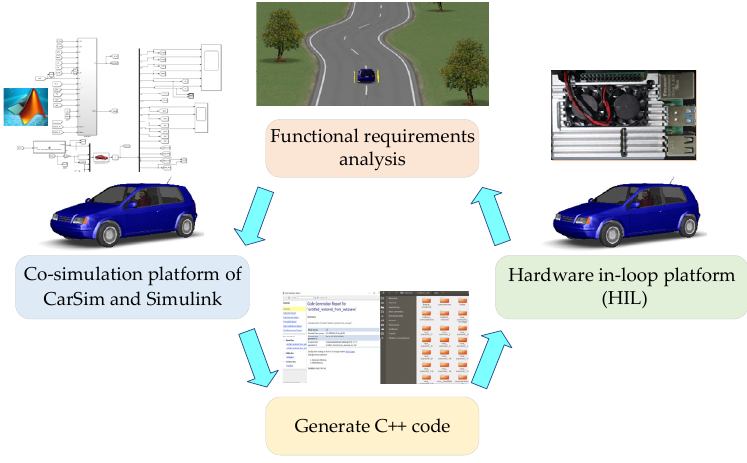
Figure 8 . Development process. Figure 8. Development